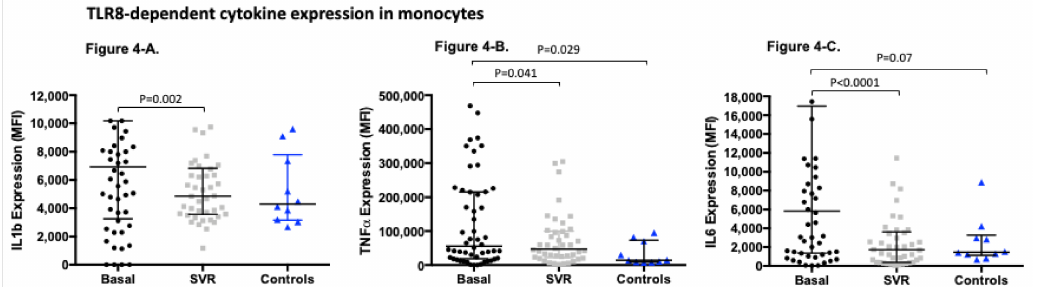
Figure 4. TLR8-dependent cytokine expression in monocytes measured as mean fluorescence intensity (MFI) (median (IQR)) in HCV patients pre and post-treatment and healthy controls: ( A ). TLR8-dependant IL1b expression in monocytes in HCV patients pre-treatment MFI (6937.0 (3254.0–10190.0)) compared to post-treatment MFI (4869.0 (3562.0–6835.0)) p = 0.002; and compared to controls MFI (4300.0 (3157.0–7793.0)) p = 0.189. ( B ). TLR8-dependant IL6 expression in monocytes in HCV patients pre-treatment MFI (5827.0 (1360.0–16971.0)) compared to post-treatment MFI (1718.0 (384.9–3609.0)) p < 0.0001; and compared to controls MFI (1468.0 (1119.0–3284.0)) p = 0.07. ( C ). TLR8-dependent TNF alfa expression in monocytes in HCV patients pre-treatment MFI (55740.0 (18550.0–215346.0)) compared to post-treatment MFI (47102.0